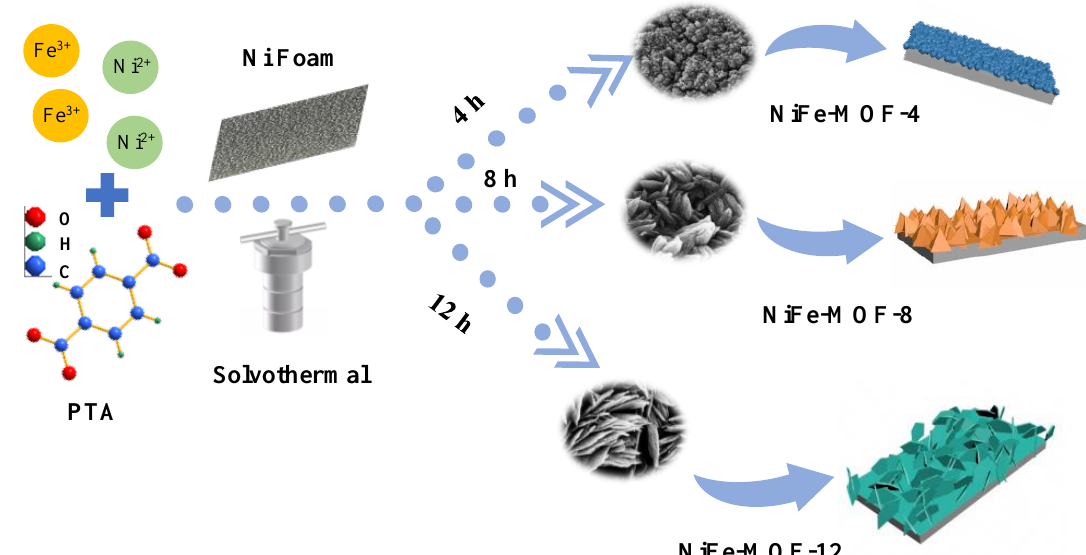
Figure 1. Diagrammatic drawing of synthesis process of NiFe-MOF-X (X = 4, 8, 12).